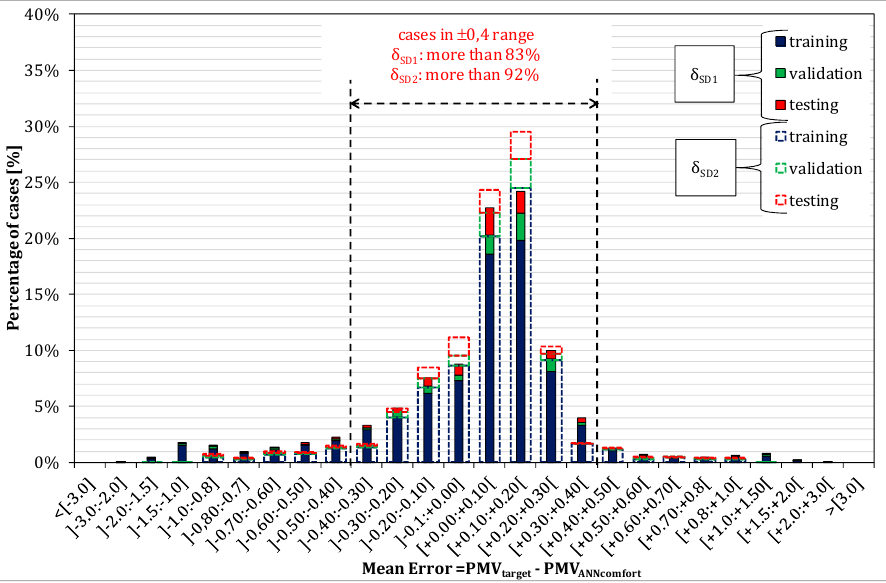
Figure 5. Neural Network Implementation: PMV mean error range returned by the ANN.